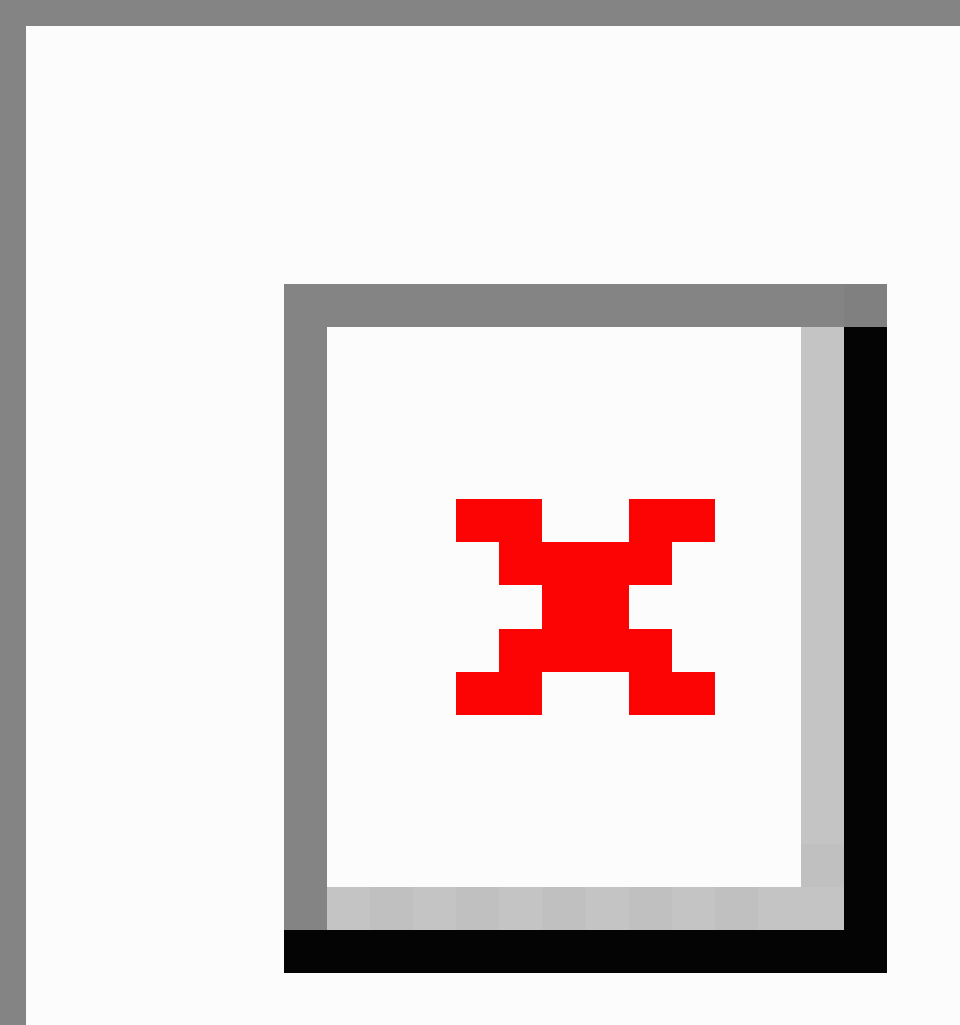
Figure 6. Specific features of the wiki tool and wiki process. Responses were entered on a 5-point Likert scale labeled as follows: 1, disagree; 3, neutral; and 5, agree. For the purposes of this figure, scores of 1 and 2 were considered “disagree,” and 4 and 5 were considered “agree.” Each bar demonstrates the proportion of participants with each response, for each statement. This includes 35 participants (5 certified asthma educators, 5 primary care physicians, 6 pulmonologists, and 19 patients with asthma). (AAP = asthma action